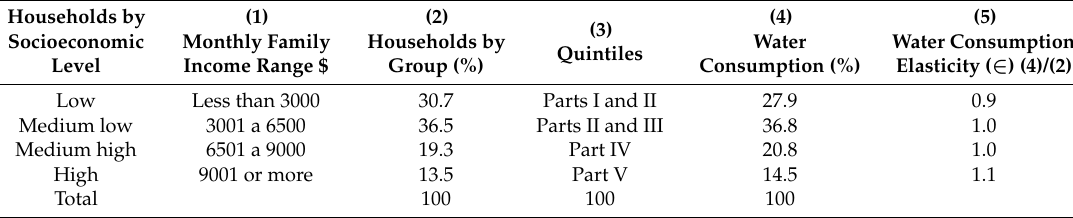
Table 1. Elasticity in water consumption by socioeconomic group in Mexico City,